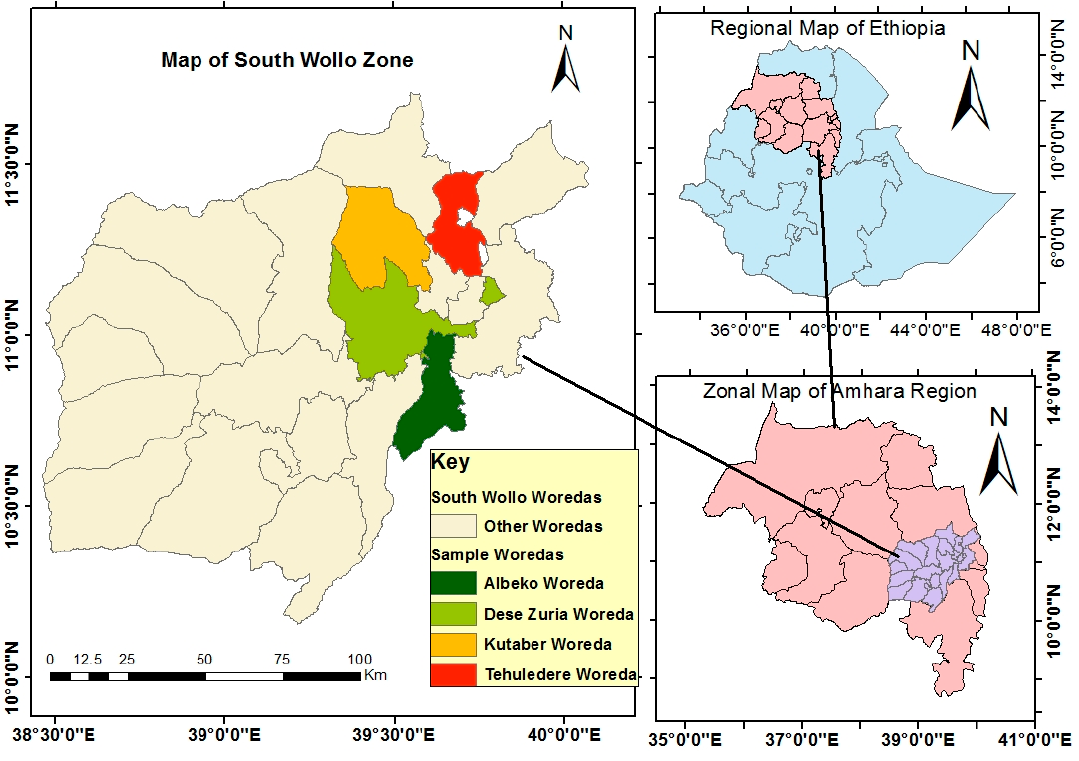
Figure 2. Selected Woredas in Amhara Regional State. 187